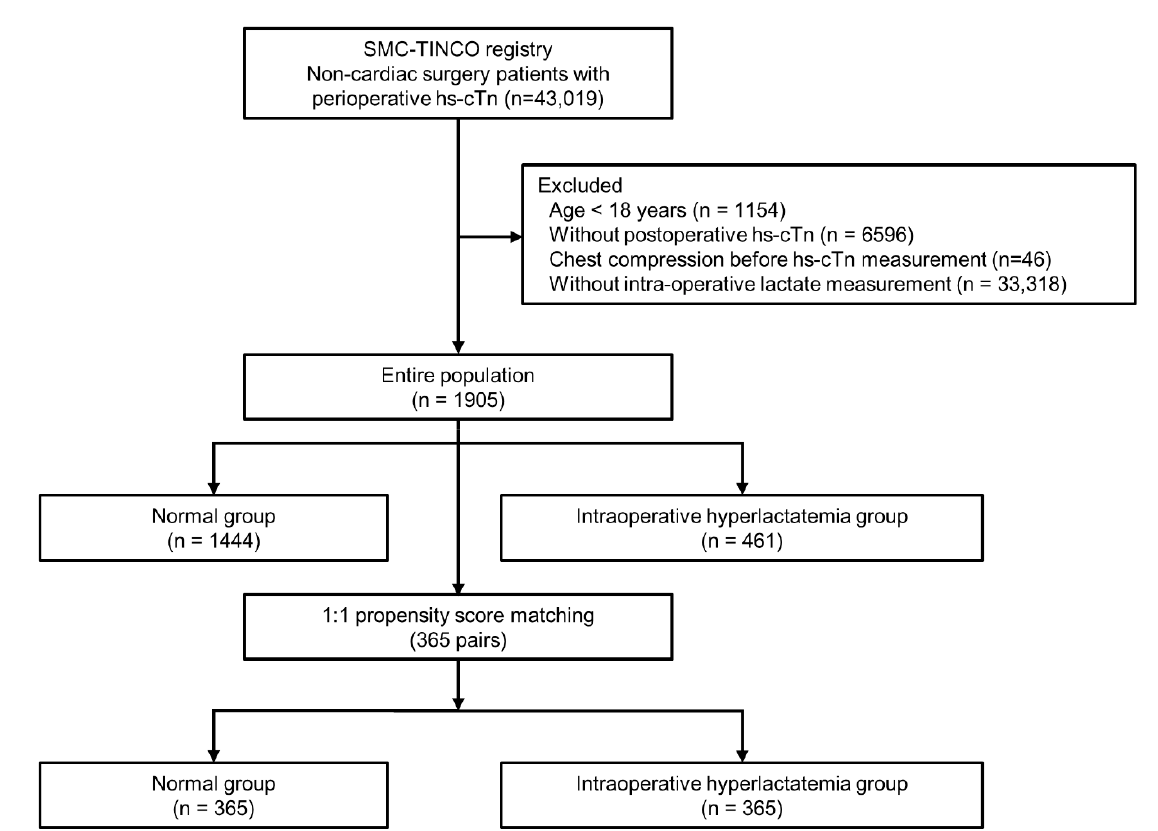
Figure 1. The flow chart of patients. SMC-TINCO: Samsung Medical Centre Troponin in Noncardiac Operation.